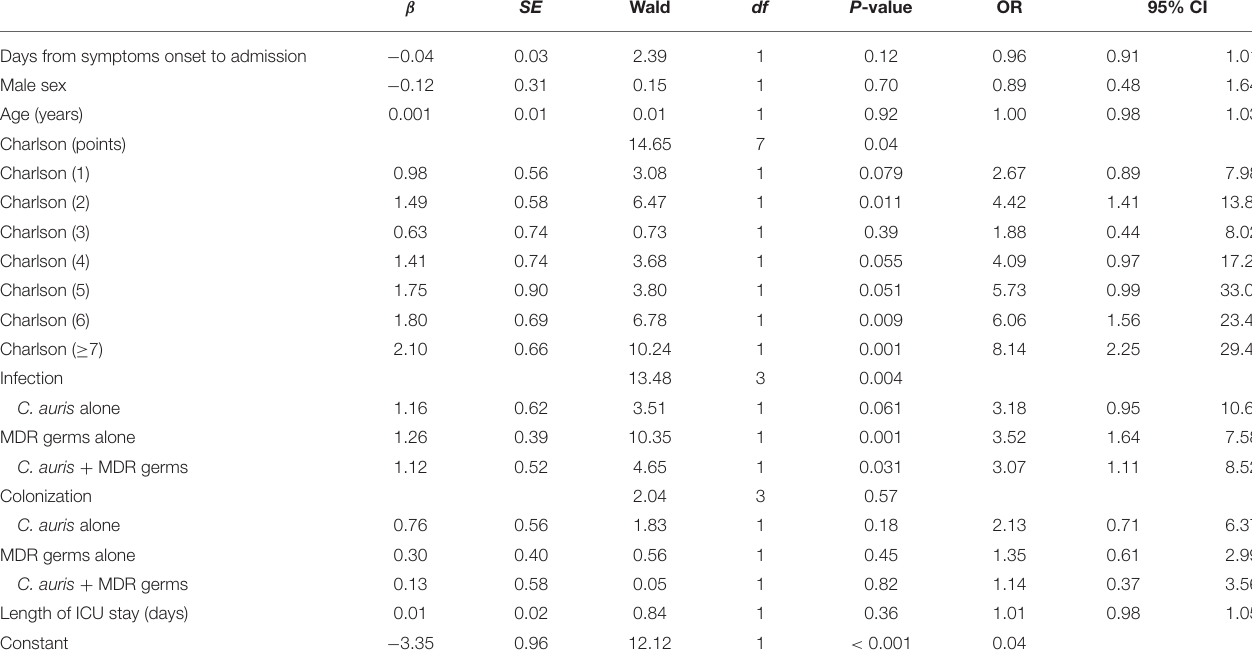
TABLE 4 | Multivariable logistic regression for mortality in patients admitted to the ICU with COVID. β SE Wald df P -value OR 95%